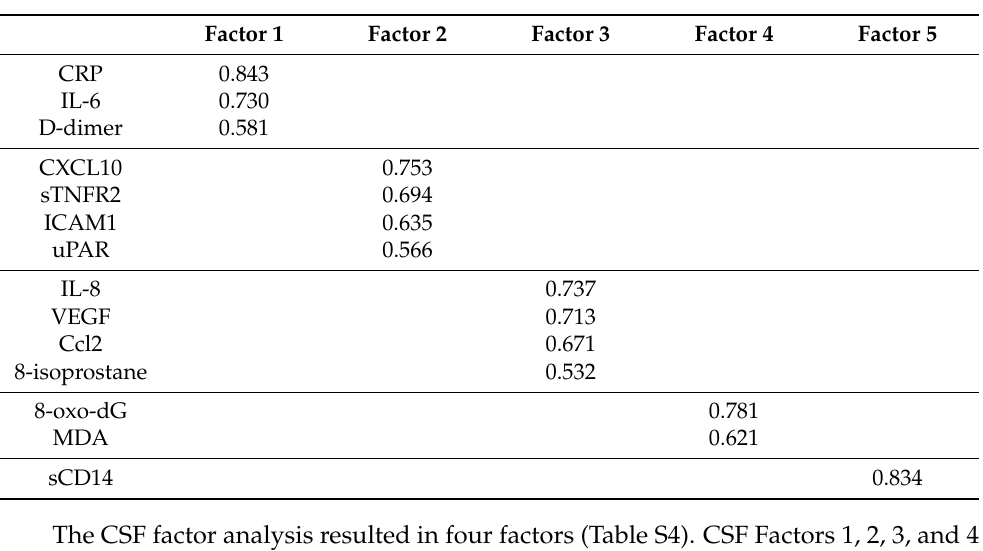
Table 2. Factor loadings of plasma